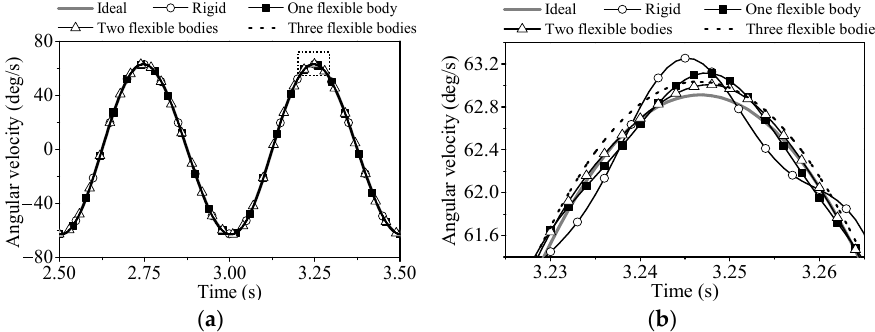
Figure 16. Angular velocity of the rigid-flexible system with different flexible body number when considering a single clearance joint: ( a ) angular velocity; ( b ) partial enlarged drawing.